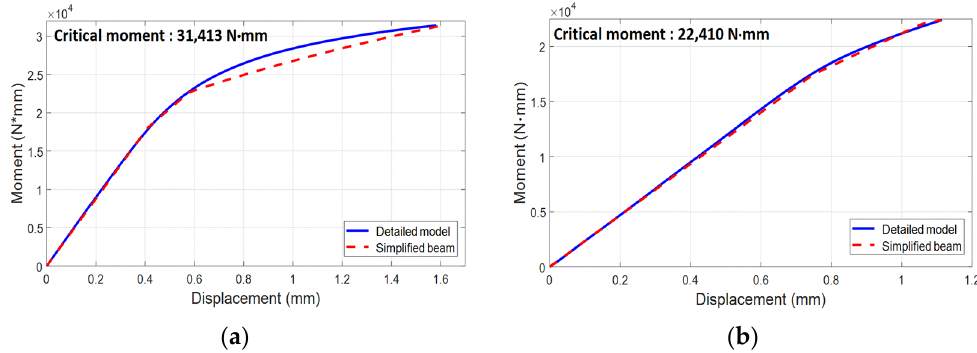
Figure 11. Moment–displacement characteristics of the detailed model and simplified model: ( a ) fully bonded condition; ( b ) fully de-bonded condition. Table 4. Results of the beam model parameter calibration.